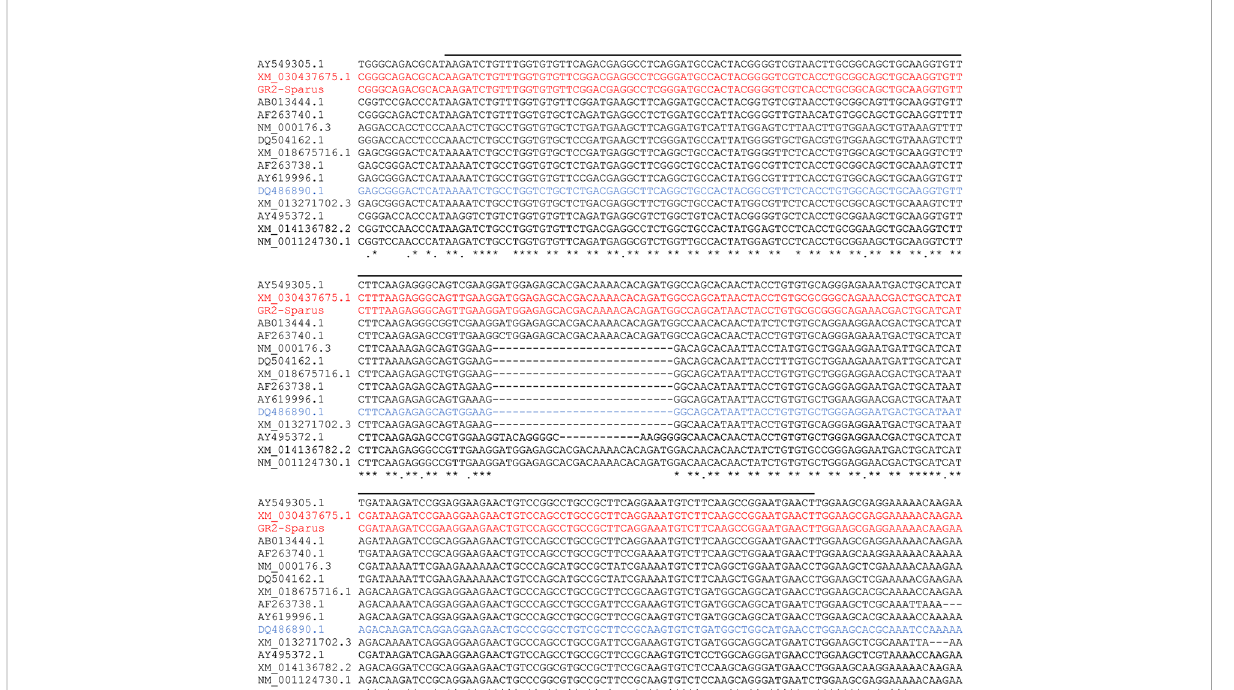
FIGURE 3 Multiple alignment for the comparison of the glucocorticoid receptors ’ nucleotide sequences at the DNA-binding region. The Clustal Omega analysis includes the glucocorticoid receptors ( gr ) sequences for several fi sh species. The DNA-binding region is denoted by the upper horizontal line throughout the alignment. The gap observed in the central band corresponds to the characteristic 27-nucleotide deletion for the identi fi cation of gr2 . The sequences associated to gr1 are detailed below according to the order of presentation (from top to bottom) in the alignment, and indicating on the left column of alignment the fi sh species and the Nucleotide accession number (NCBI), represented: AY549305.1 for European sea bass ( Dicentrarchus labrax ); XM_030437675.1 (99% identity with our sequenced PCR product; indicated in red) and GR2-Sparus aurata TR96646|c2_g1_i11 for gilthead sea bream [ S. aurata ; indicated in red and described in Tsalafouta et al. (2018)]; AB013444.1 for Japanese fl ounder ( Paralichthys olivaceus ); AF263740.1 for Burton ’ s mouth-brooder ( Astatotilapia burtoni ); XM_014136782.2 for Atlantic salmon ( Salmo salar ); and NM_001124730.1 for rainbow trout ( Oncorhynchus mykiss ). The sequences for the outgroup were (from top to bottom) NM_000176.3 for humans ( Homo sapiens ), and DQ504162.1 for mice ( Mus musculus ). The sequences associated with gr2 were (from top to bottom) the XM_018675716.1 for Asian sea bass ( Lates calcarifer ); AF263738.1 for Burton ’ s mouth-brooder ( A. burtoni ); AY619996.1 for European sea bass ( D. labrax ); DQ486890.1 for gilthead sea bream ( S. aurata ; de fi ned by Acerete et al. (2007) as glucocorticoid receptor; indicated in blue); XM_013271702.3 for Nile tilapia ( Oreochromis niloticus ); and AY495372.1 for rainbow trout ( O. mykiss ). The "*" (asterisk) indicates positions which have a single, fully conserved residue. The ":" (colon) indicates conservation between groups of strongly similar properties. The "." (period) indicates conservation between groups of weakly similar